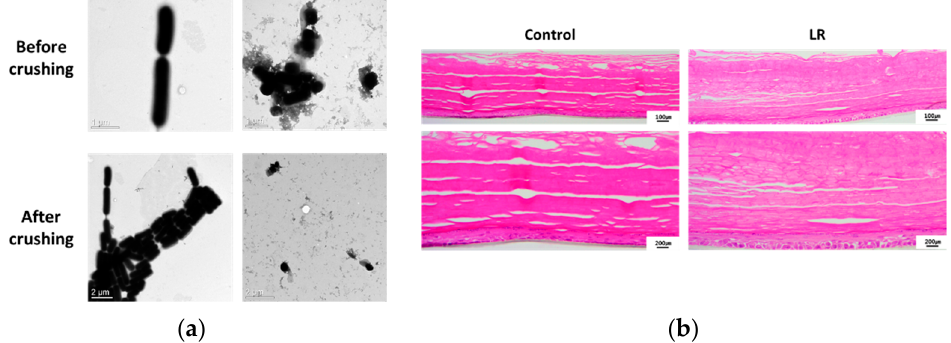
Figure 1. Lysates of Lactobacillus rhamnosus (LR) and its effect on Keraskin TM . ( a ) Microscopic images of LR lysate before and after crushing . ( b ) Histology of H&E stained Keraskin TM after LR lysate treatment. LR lysate was topically applied to Keraskin TM every other day 8 times. Control; PBS.